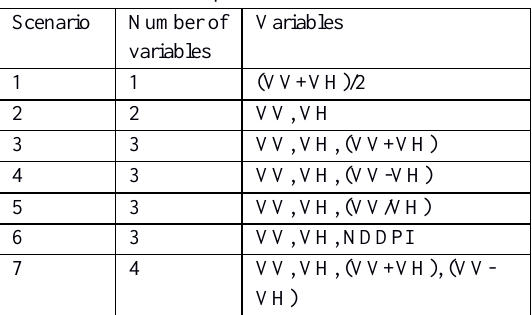
Table 1. dataset of experiments for land cover classification Scenario